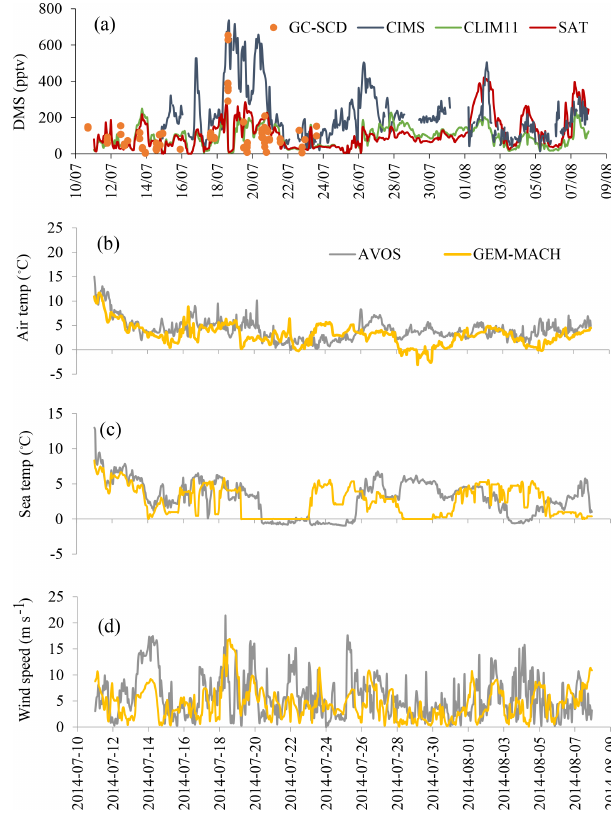
Figure 7. (a) The campaign-mean DMS(g) mixing ratios for the co- sampled GEM-MACH simulations (SAT and CLIM11) and mea- surements onboard the Amundsen from 11 to 24 July (GC-SCD), and from 15 July to 8 August (CIMS). (b–d) Wind speed as well as sea and air temperatures from the Amundsen ’s AVOS system and